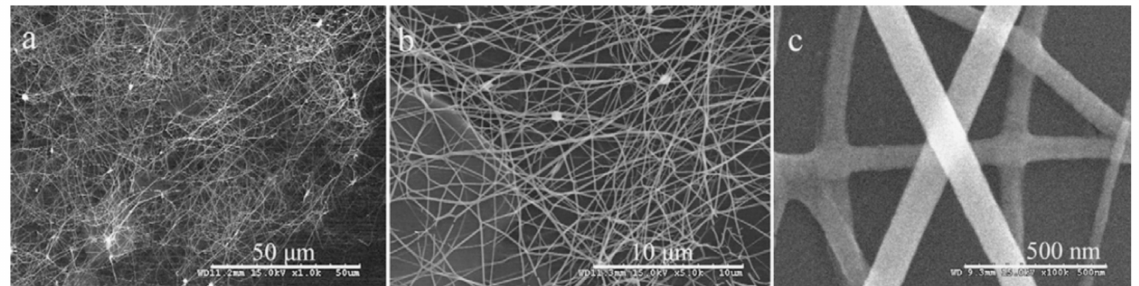
Figure 33. ( a–c ) SEM images of SnO 2 nanofibers with different magnifications ( T an = 700 ◦ C). Reprinted with permission from [105]. Copyright 2008